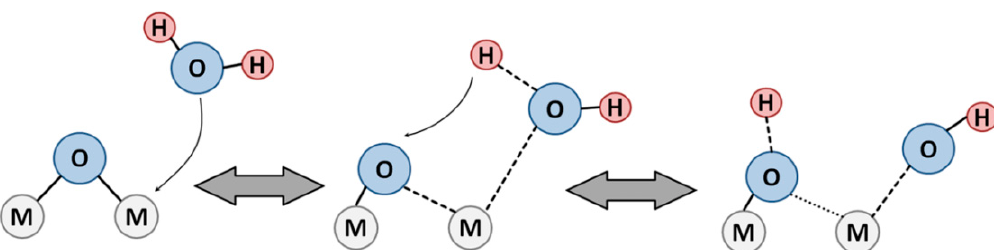
Figure 6. Scheme of water molecule dissociative adsorption at metal oxide surface with the formation of bridging and terminal OH-groups. Reprinted with permission from ref. [84]. Copyright 2018 Springer.